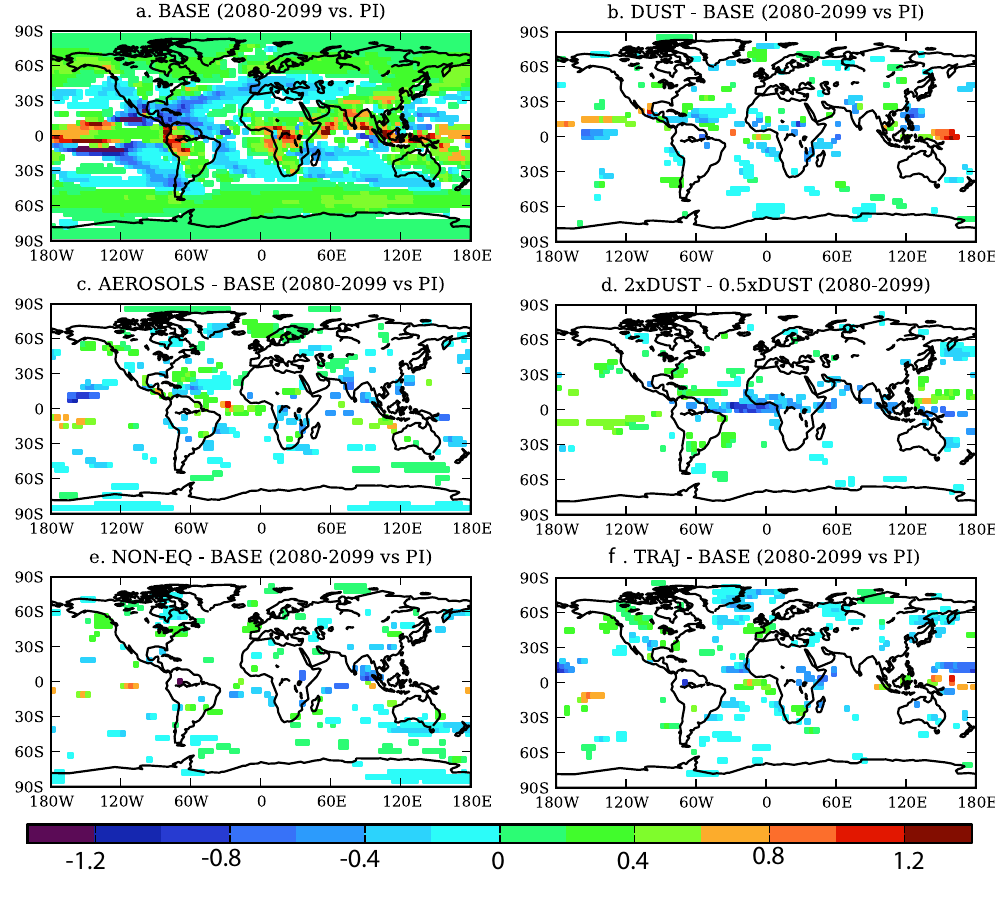
Fig. 9. Same as Fig. 8, but for precipitation (mmday − 1